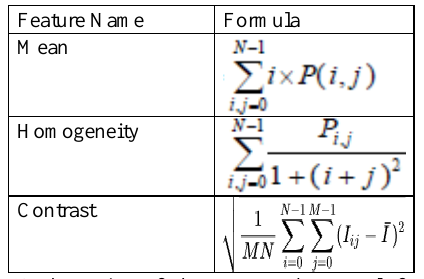
Table 1. Mathematics of the measured textural features on SPOT image